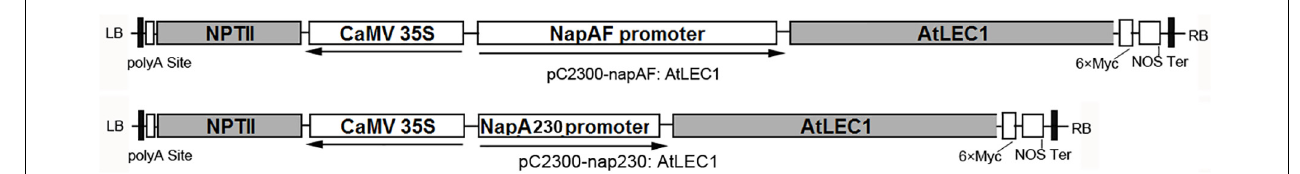
FIGURE 1 | Structures of plant expression vectors harboring the foreign AtLEC1 gene driven by Napin A full-length or 230-bp